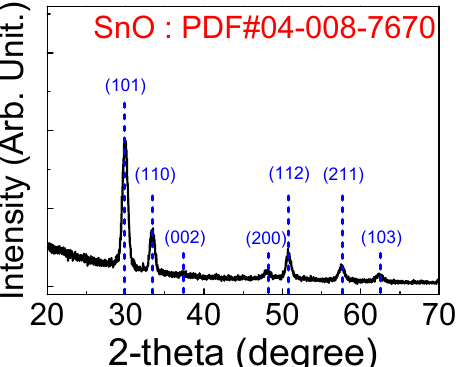
Figure 2. ( a ) Field-emission scanning electron microscopy (FE-SEM); ( b ) atomic force microscopy (AFM) images of the 16-nm-thick SnO X thin film deposited on the thermally oxidized SiO 2 /n + -silicon substrate.